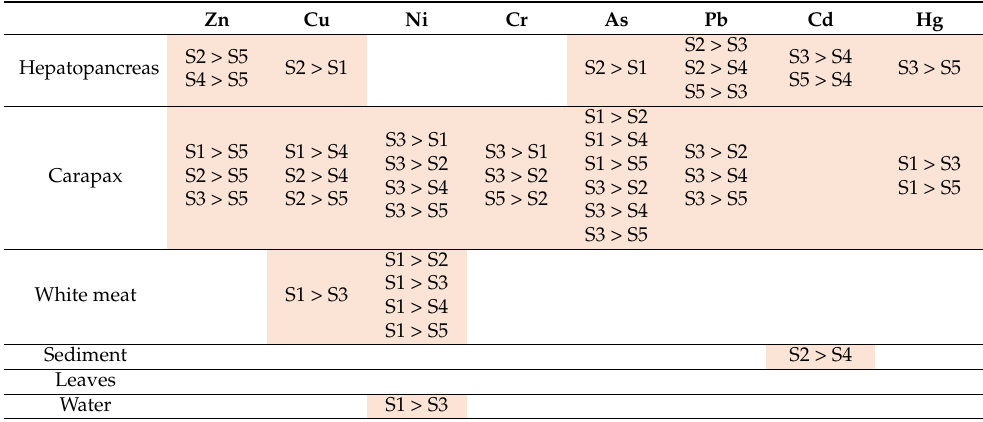
compartments at the five stations.